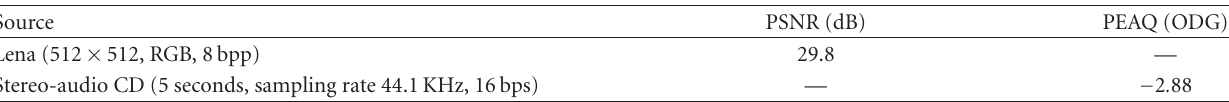
Figure 12: Percentage bandwidth gain for fixed quality on the transmitted parameter u 1 ( τ ) (a) and u 2 ( τ ) (b) achieved by UPA against UEP by RS codes for the WPDM scheme in Figure 7. Table 4: Quality achieved by the proposed system at P b = 10 − 3 for the multiple transmission of the image Lena and a stereo-audio CD sequence.